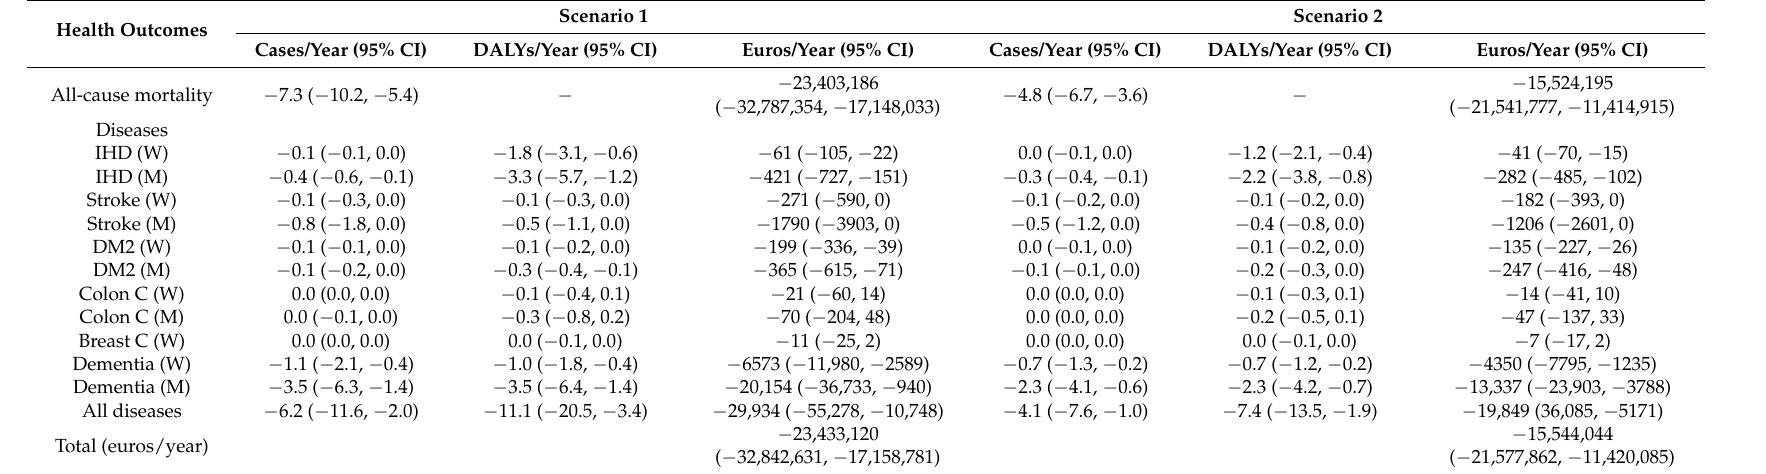
Table 2. Results in annual cases of mortality, diseases, DALYs, and health-related economic outcomes due to the intervention. Results provided for Scenario 1 (assuming that 100% of the physical activity conducted in the park was new physical activity), and Scenario 2 (assuming that 50% of the physical activity conducted in the park was new physical